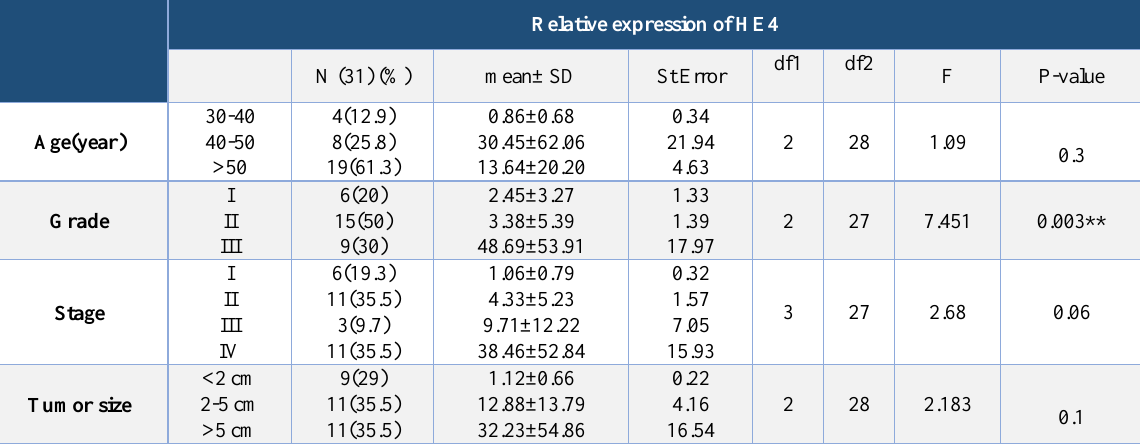
Fig. 3. A: Plasma HE4 expression in four stages of breast cancer. A significant increase in plasma HE4 of stage IV (n=12) BC patients was observed compared with stage I (n=7) ( P <0.01) and stage II (n=17) ( P <0.05). Plasma HE4 expression was shown to have a significant increase in stage III (n=7) compared with stage I BC patients ( P <0.05). Also, plasma HE4 expression has a statistically significant correlation with tumor size ( P <0.01). B: Plasma HE4 expression in early stages of breast cancer (n=24) compared with healthy control group (n=43). The figure shows significant upregulation of plasma HE4 in early stages of breast cancer as compared to healthy individuals ( P <0.01). Table 2. Association between HE4 relative expression in BCT samples and clinicopathological features. Results of one-way ANOVA parametric